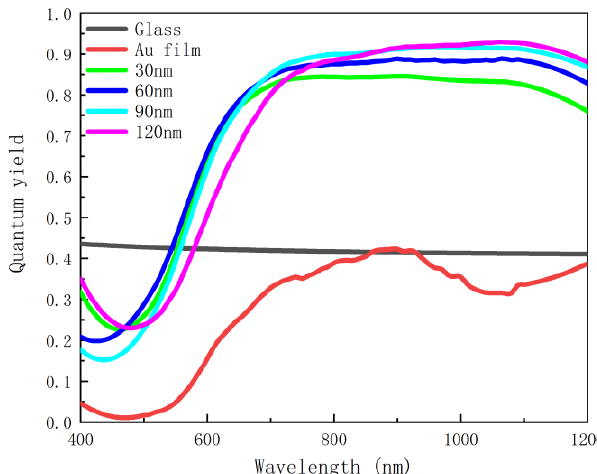
Figure 6. Quantum yield as a function of wavelength with different hemisphere radii.